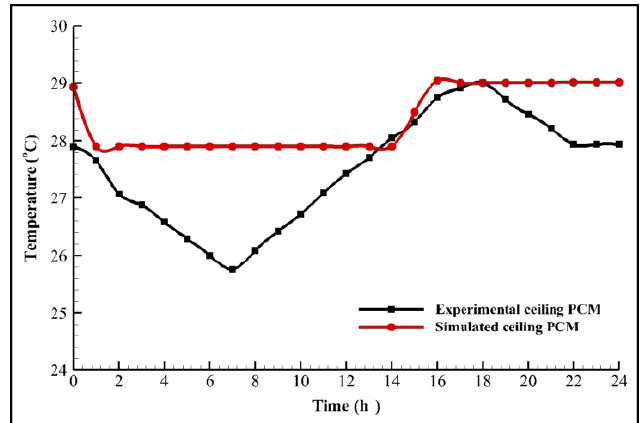
Figure 21. Experimental and simulated temperature of the REF roof.